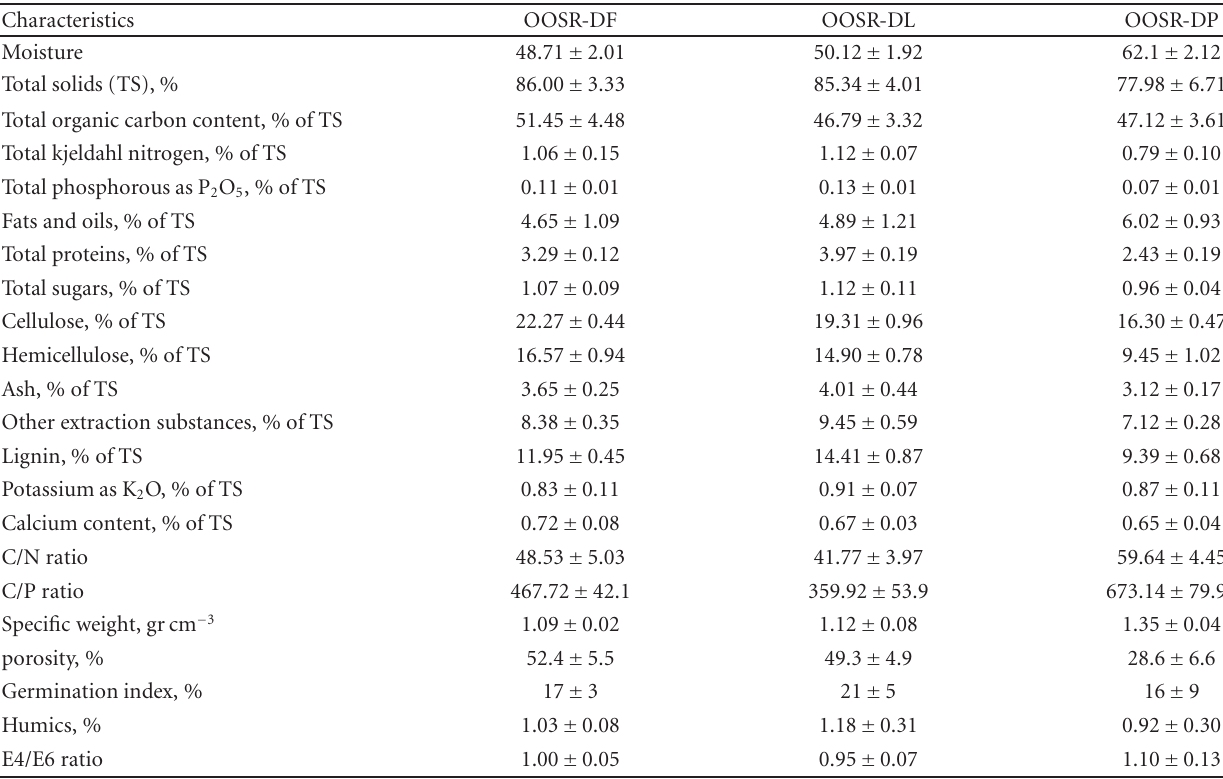
Table 3: Composition of the olive oil solid residue.